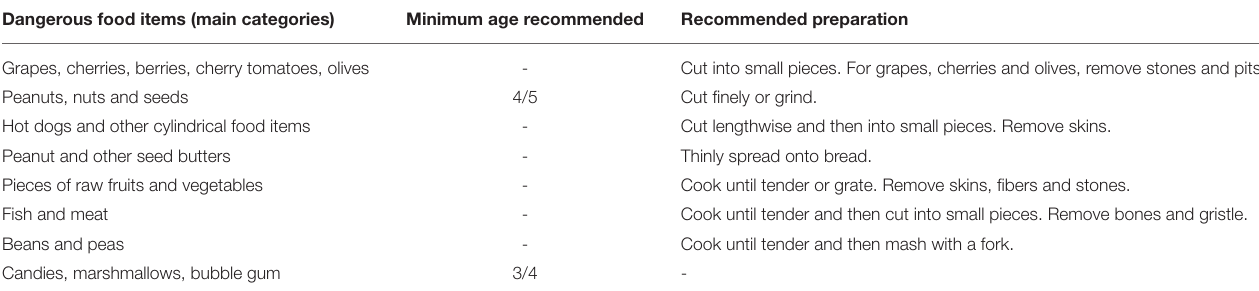
TABLE 2 | Core recommendations in food preparation and serving derived from the overviewed guidelines. Dangerous food items (main categories) Minimum age recommended